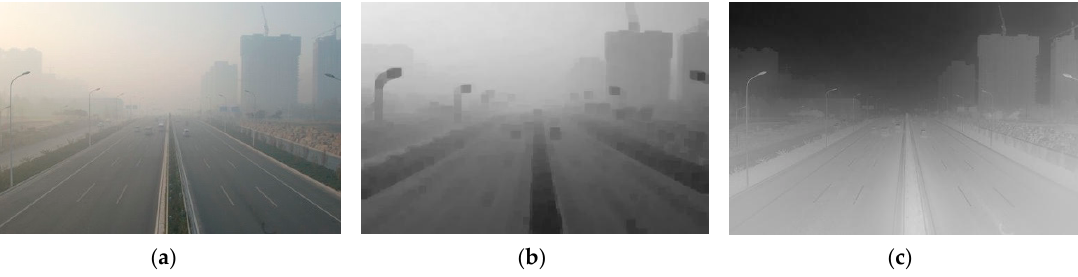
Figure 1. The images of the DCP algorithm. ( a ) The original image. ( b ) The dark channel image. ( c ) The transmittance image.